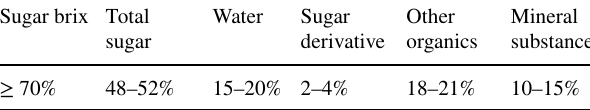
Table 1 Sugarcane molasses components parameters Sugar brix Total Water Sugar Other Mineral sugar derivative organics